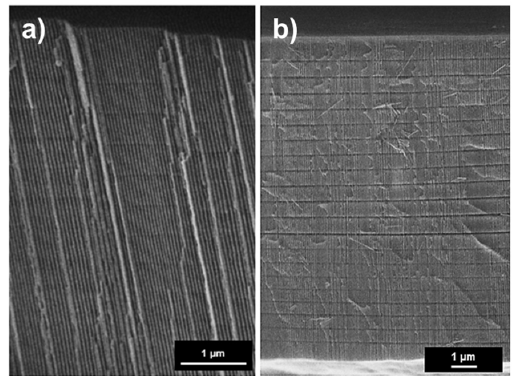
Figure 4. Cross ‐ sectional images of ( a ) S360 and ( b ) S540 type samples.